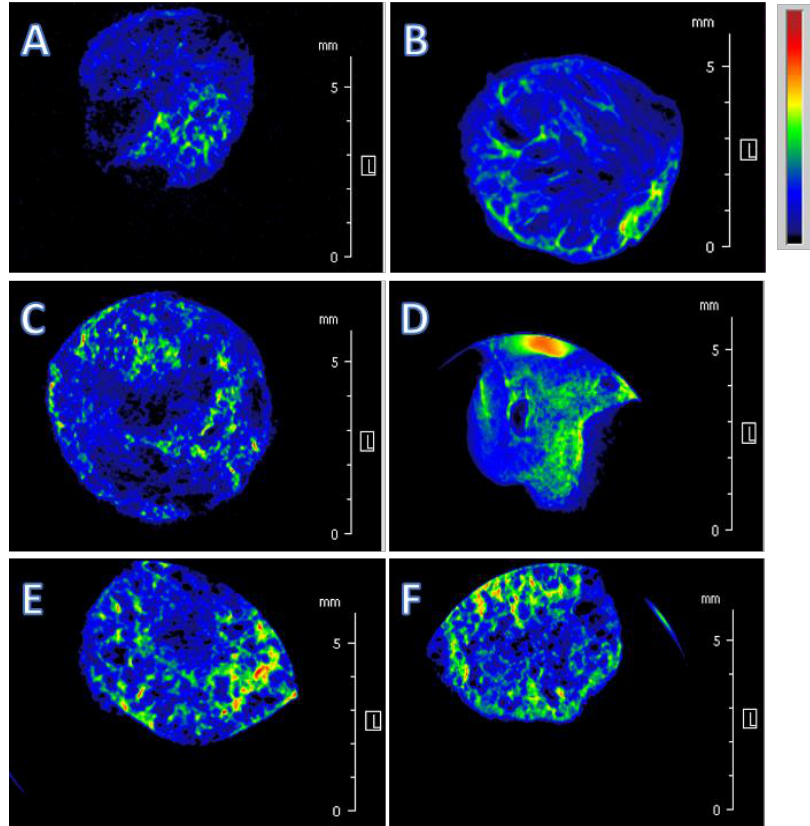
Figure 3. MRI images showing a representative central slice of each hydrogel after the addition of 150 µ L of water necessary to saturate samples: ( A ) H-LMP, ( B ) H-HMP, ( C ) H-LMP-HS, ( D ) H-HMP-HS, ( E ) H-LMP-HULIS, ( F ) H-HMP-HULIS. The MRI images show the spatial distribution of water within the structure of samples, varying the color from blue to green and pale red as a function of increasing water content.